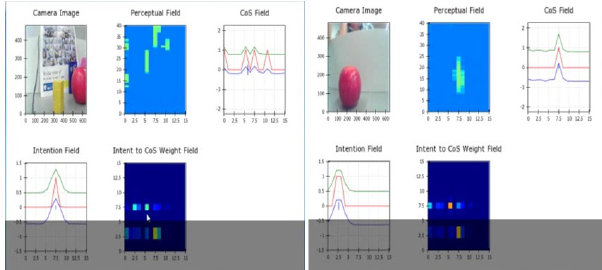
Figure 6: Snapshots of the E-Puck’s dynamic fields during the learn- ing. Left: The primary intention (drive) “thirst” is activated, which is satisfied by perception of the yellow color. When the rewarding signal is received, three colors are prevalent in the observed scene – yellow, red, and blue, and these all leave memory traces in the weights connecting the intention and the CoS DNFs. When learning continues and rewards are experienced in different scenes, the cor- rect mapping activated, which is satisfied by the perception of the red color. Since only the red object is present in robot’s view when the rewarding signal is received, a single peak is activated in the CoS field and only weights towards its location are